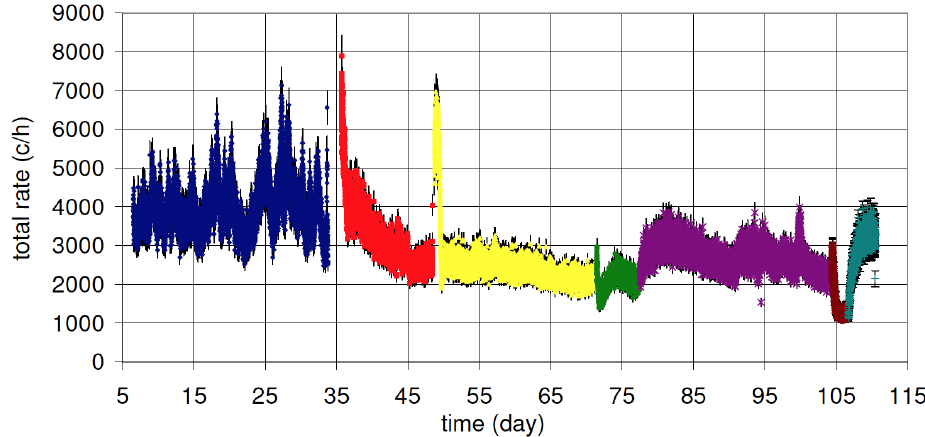
Figure 10. NaI(Tl) total rate as a function of time for different tests: blue —Castle closed; red —Castle closed with improved tightness; yellow —Castle closed with 7 h N 2 purge at 1800 L/h; green — Castle closed with N 2 purge + constant N 2 flux 180 L/h; violet —Castle closed without N 2 flux; brown —Castle closed with N 2 purge + N 2 flux 900 L/h; turquoise —Castle closed without N 2